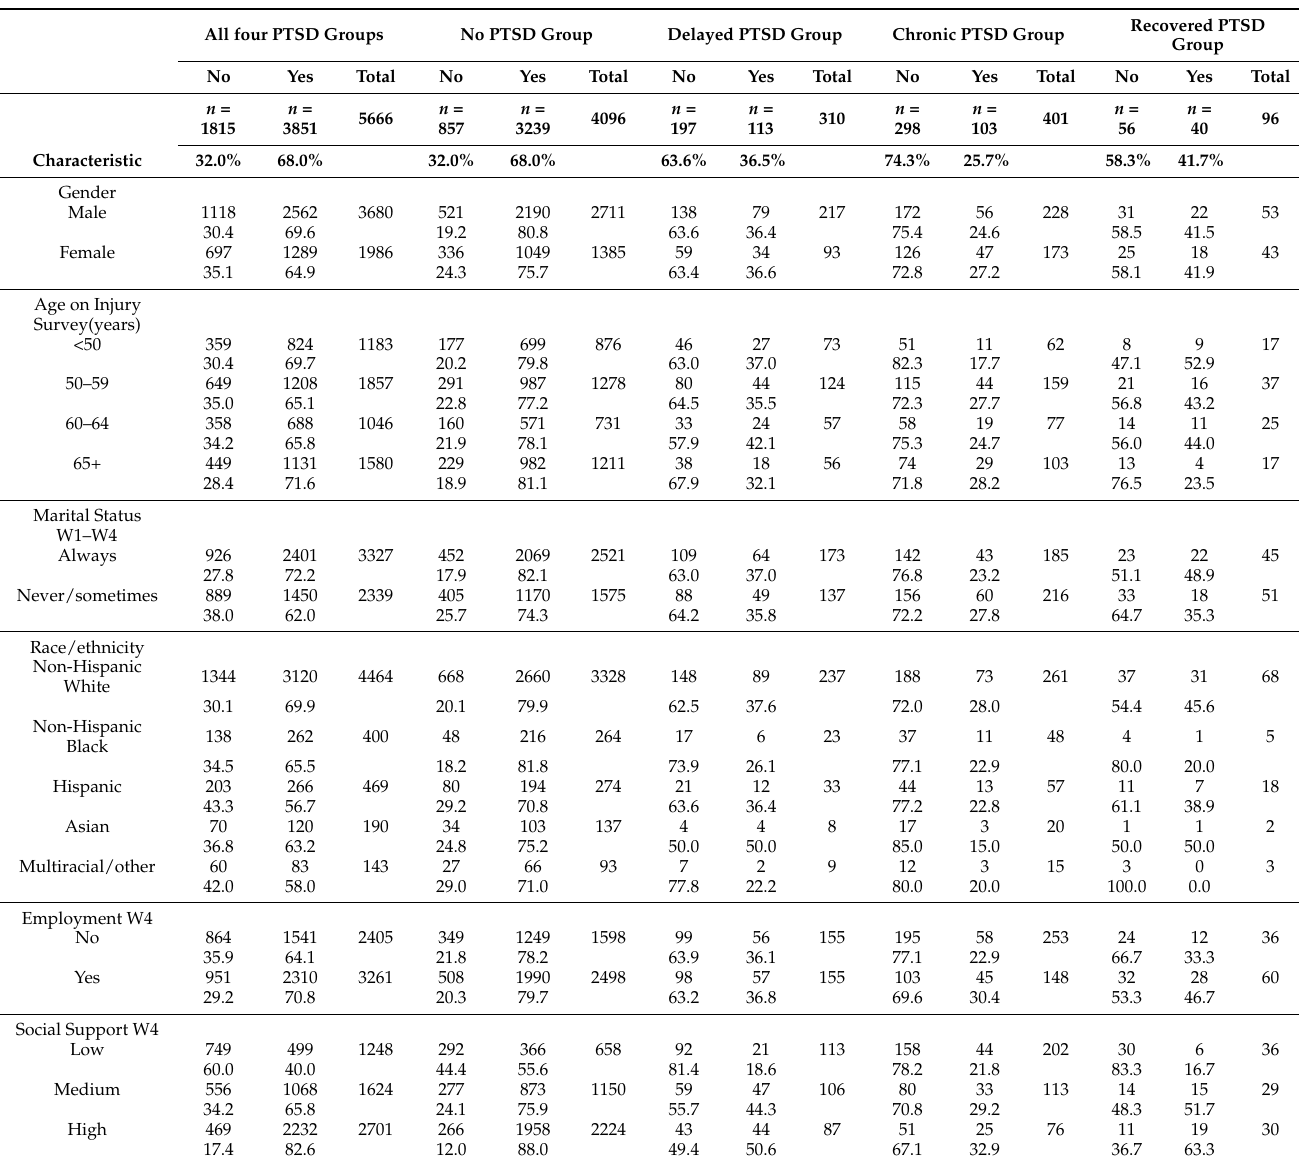
Table 3. Distribution of demographic factors and psycho-social factors with emotional embeddedness, stratified by PTSD